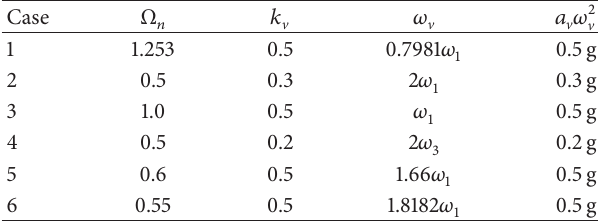
Table 1: Excitation parameters for the test cases shown in Figure 4.